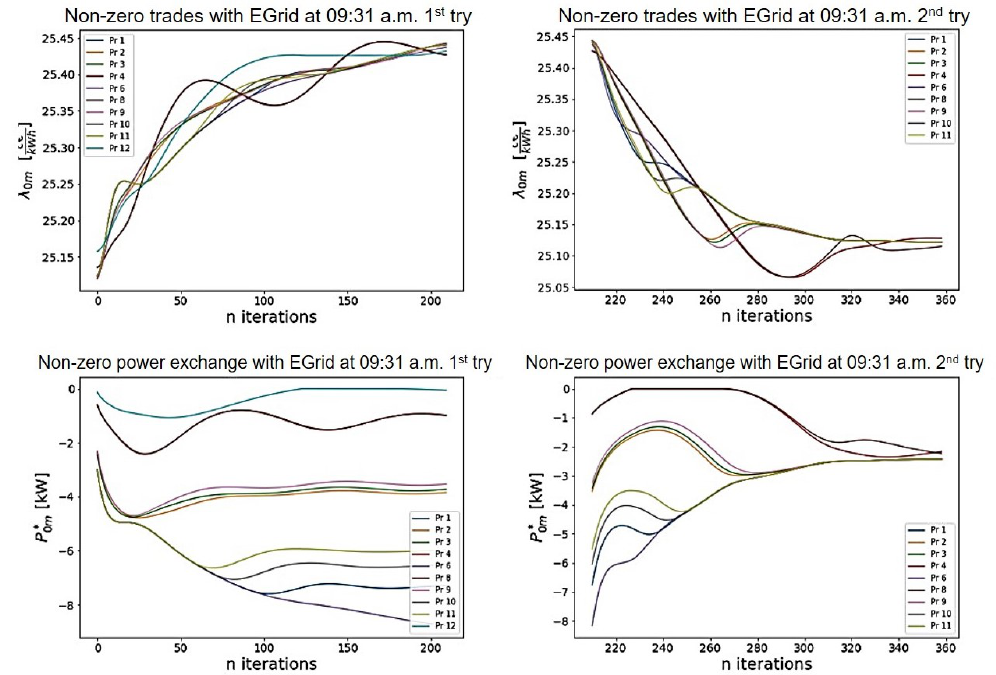
Figure 7. RCI λ -convergence and power convergence of an over-voltage occurrence at prosumer 12’s bus. ( Left ): Over-voltage congestion occurs. ( Right ): Congestion is fixed. Time step: 09:31